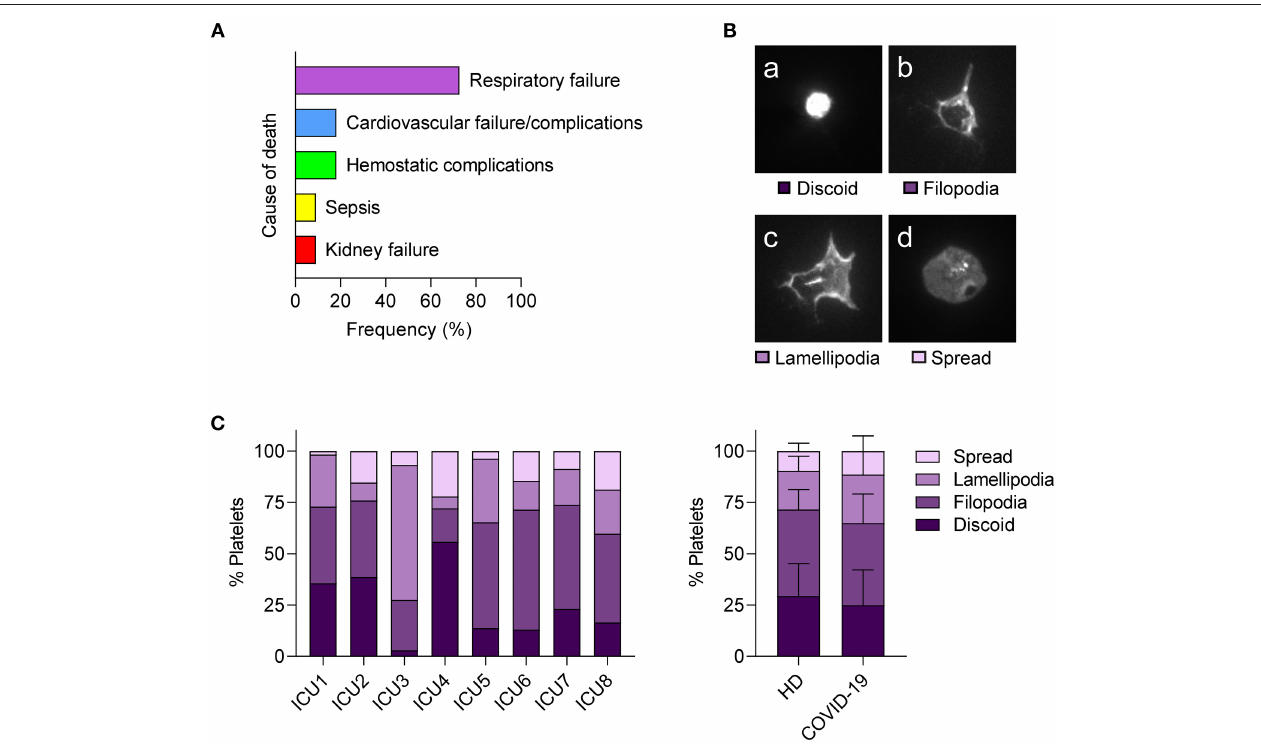
FIGURE 4 | Hemostatic complications are common in fatal COVID-19 but platelets from severe COVID-19 cases show normal spreading. (A) Relative frequency of listed cause of death among fatal cases within the prospective study cohort. n = 11 patients. (B,C) Platelets of patients with COVID-19 requiring ICU or healthy controls were seeded on fibrinogen (30min) and platelet spreading evaluated by immunofluorescence. (B) Platelets were classified into four stages: (a) discoid, (b) filopodia-forming, (c) lamellipodia-forming, and (d) fully spread. (C) Relative abundance of platelet spreading stages of individual patients with COVID-19 (left panel). Mean percentages of platelets in different spreading stages were compared between healthy donors (HD) and patients with COVID-19 (right panel). Differences between HD and patients with COVID-19 were tested by two-way ANOVA. N = 7 healthy donors/8